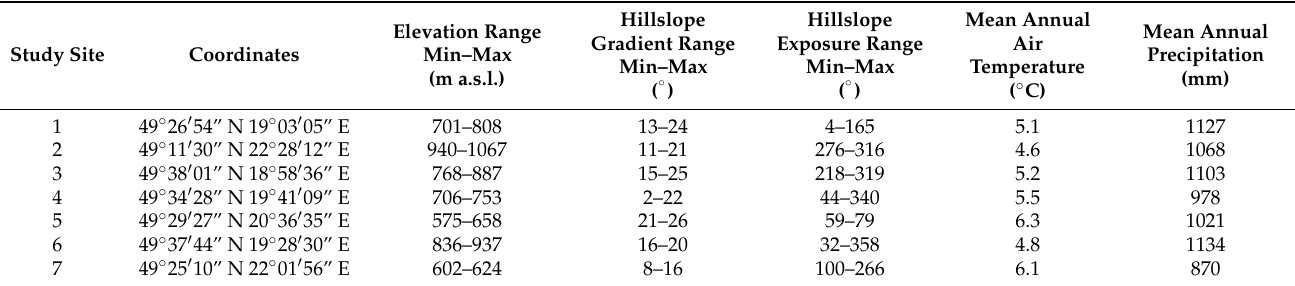
Table 1. Characteristics of the investigated study